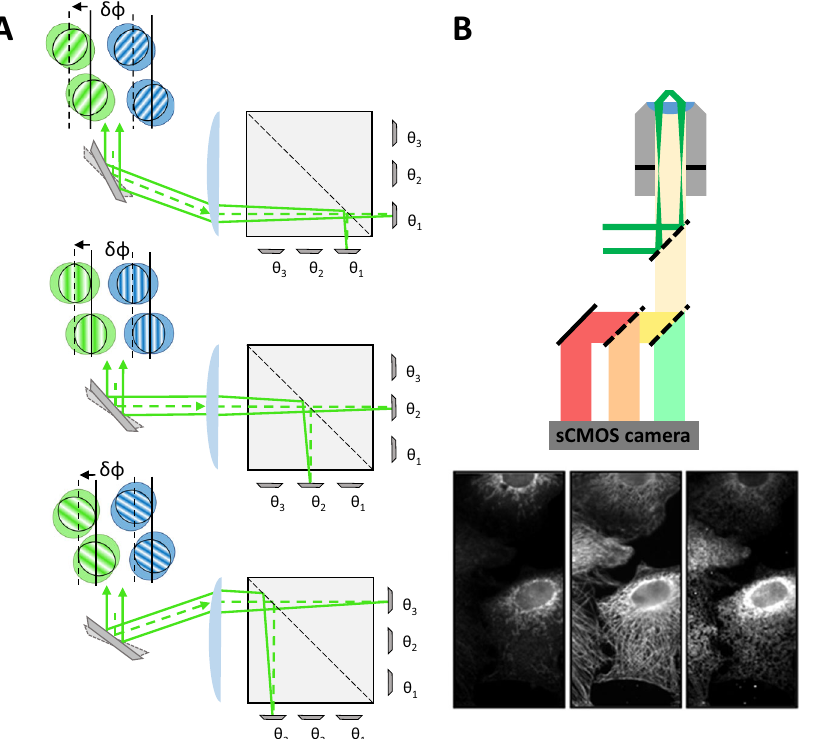
δϕ , in the excitation pattern. Different wavelengths (blue and green patterns) produce fringes with different spacing and hence an unequal phase shift. B Schematicofdetectionoptics.Usingseveraldichroicmirrorsandemission fi lters, thethree-wayimagesplitterallowsforthesimultaneousdisplayofuptothreecolor channelsonthecamerachip.Forfulldetailsontheopticalsetupandarenderingof the layout, see Supplementary Fig.